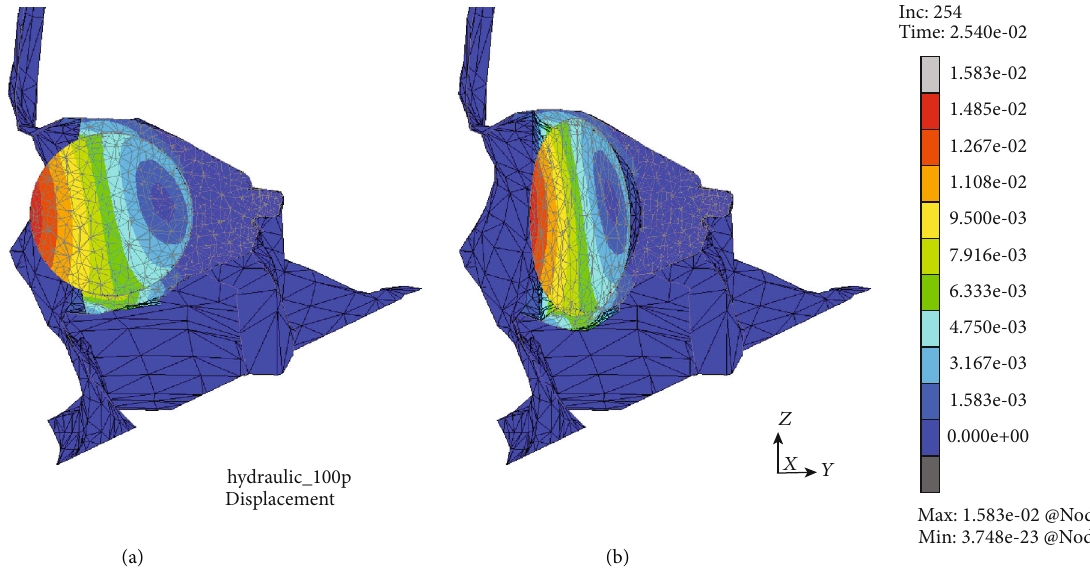
Figure 9: Displacement map (mm) for the sagittal cross section of the MOBOSE: (a) without deformation and (b) with